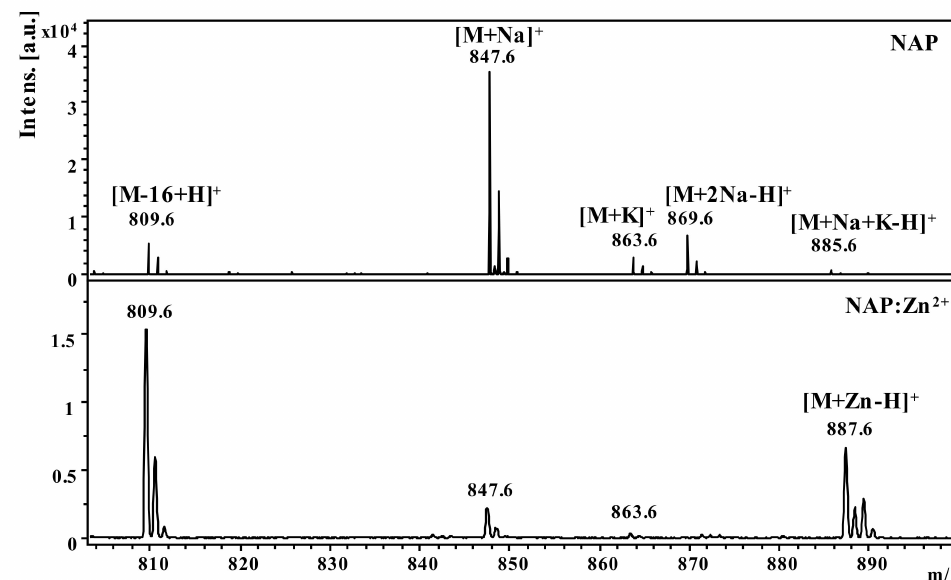
Figure 1. MALDI ToF MS spectra of the NAP peptide in the presence and absence of zinc ions at a 1:10 peptide to metal ratio.